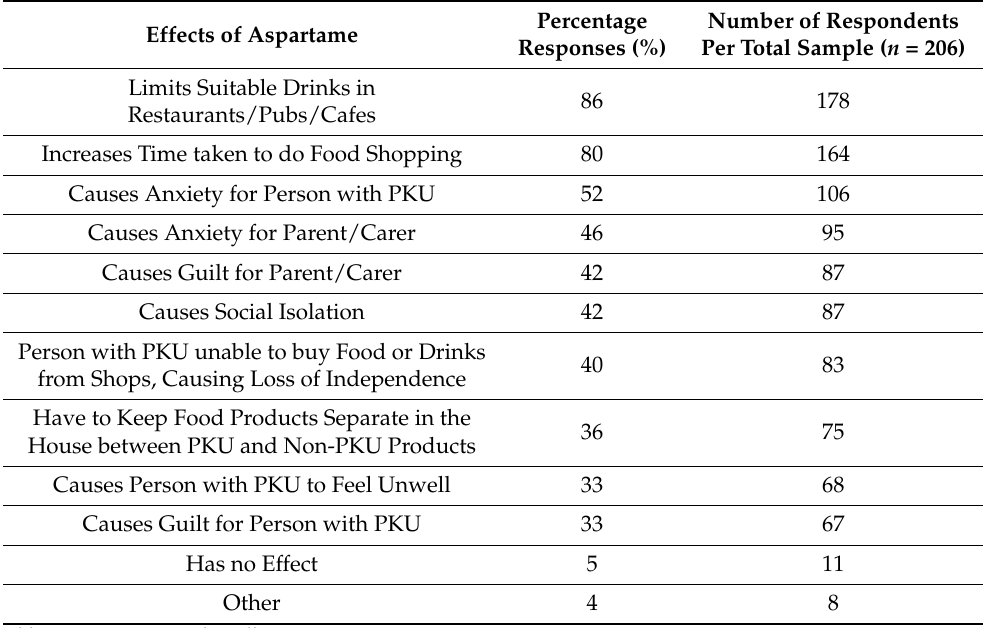
Table 6. Reported effects of aspartame on the person with PKU and